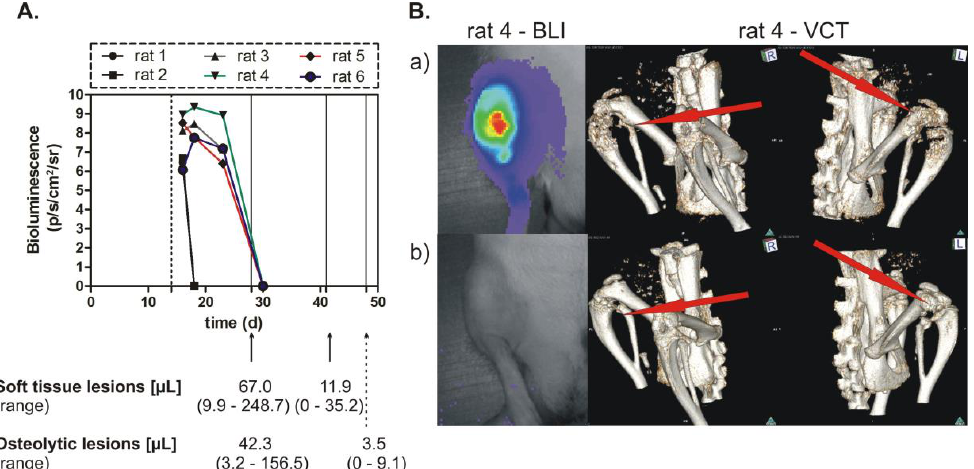
Figure 4. Inhibition of breast cancer skeletal metastasis upon conditional miRNA-mediated OPN knockdown. ( A ) Bioluminescence imaging (BLI) detection of tumor cells and measurement of the volume of soft tissue and osteolytic lesions. Cells of the clone O1 were inoculated into nude rats, which received doxycycline for 2 weeks (dashed line indicates the end of this administration) and were exposed to miRNA treatment thereafter. The time after tumor cell inoculation (days) is given on the x -axis; bioluminescence was measured in photons/second/cm 2 /steradian; the volume of soft tissue and osteolytic lesion is indicated at 28, 42 or 49 days after tumor cell inoculation or 14, 28, or 35 days of miRNA treatment. ( B ) BLI and volume computed tomography (VCT) images of tumors and skeletal metastasis. In the upper panel ( a ) are the BLI image (left) and VCT scans (middle and right), which show the status at 19 and 28 days after tumor cell inoculation, respectively; the lower panel ( b ) shows the BLI image (left) and VCT scans (middle and right), which indicate the status at 30 and 49 days after tumor cell inoculation, respectively.